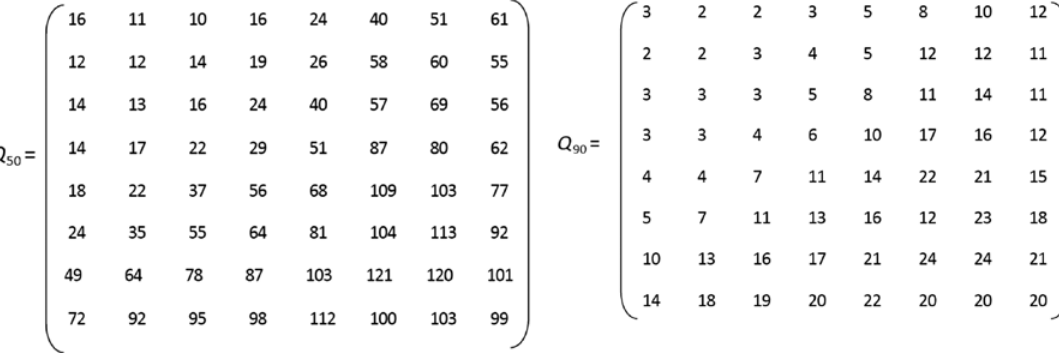
Figure 2: JPEG Standard Quantization Matrices of Quality Levels Q